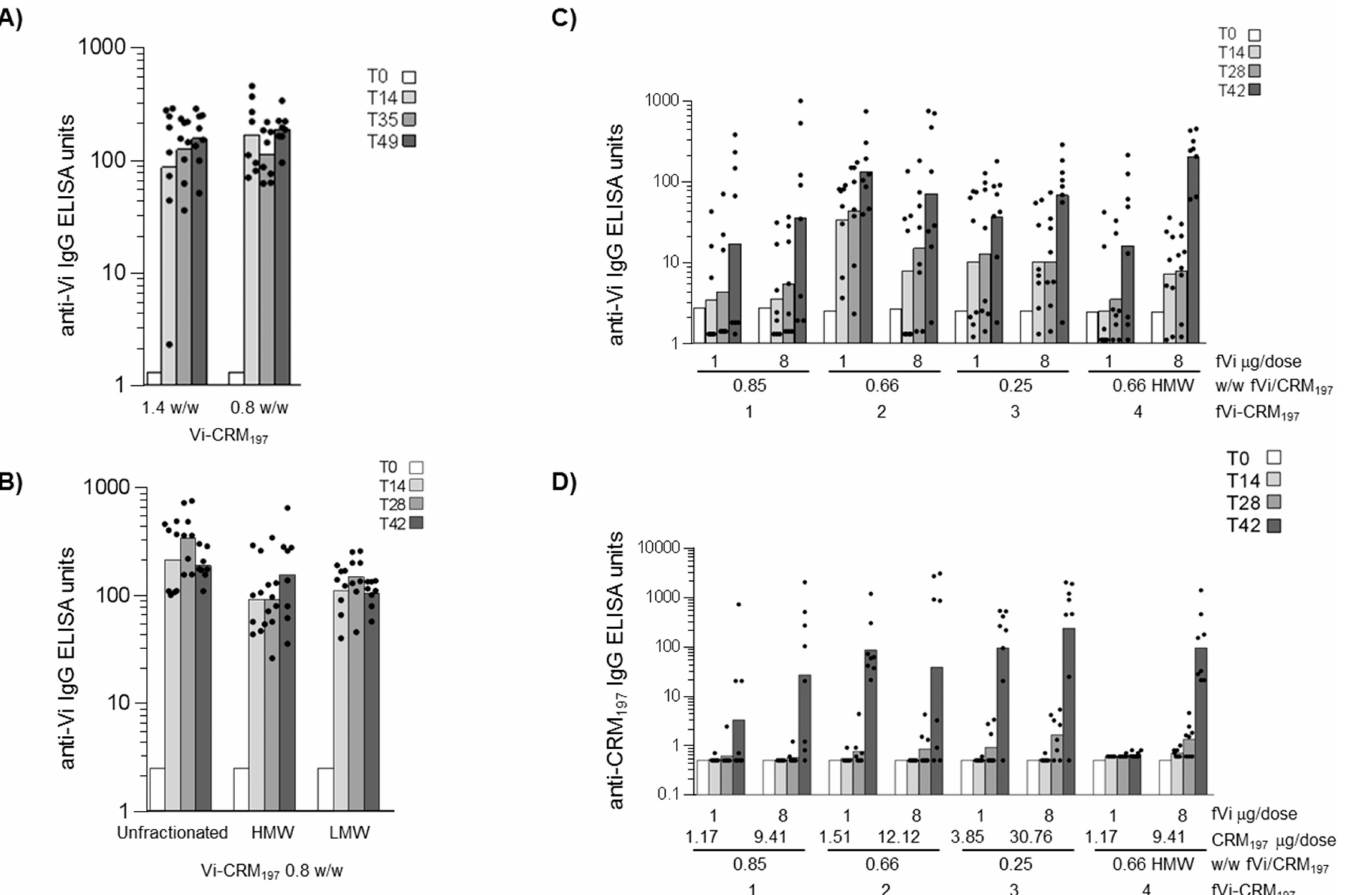
Fig 3. Influenceof saccharide to protein ratio and conjugatesize on: anti-Vi IgG responseinducedin mice by Vi-CRM 197 (A and B respectively) and fVi- CRM 197 conjugates (C); anti-CRM 197 IgG responseinducedin mice by fVi-CRM 197 conjugates (D). Ten weeks old CD1 mice were immunized at days 0 and 28 or 35 at 1 μ g (A, B) and 1 or 8 μ g (C) Vi/dose. Bars representthe geometricmean ELISA units of the group in log scale, individualanimalsare represented by the scatter plots. HMW and LMW indicate highmolecularweight and low molecularweight conjugates.